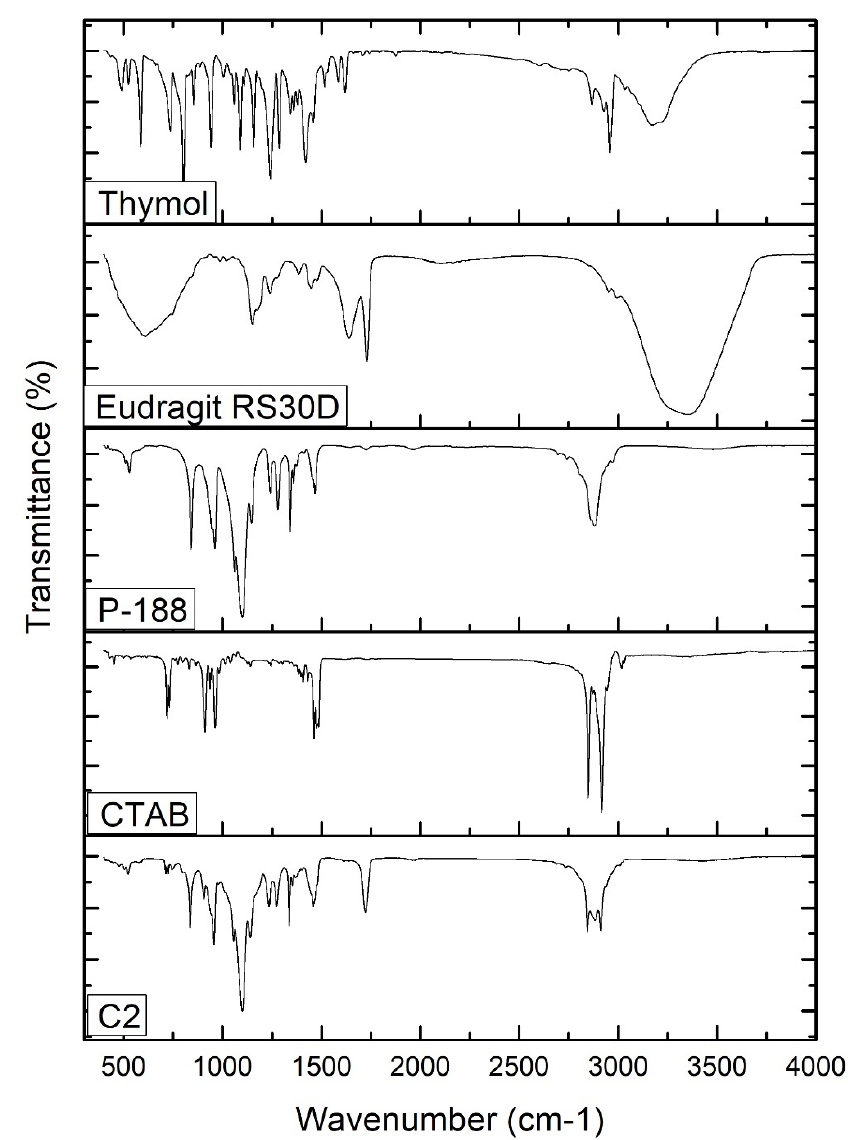
Figure 3. FT-IR spectra of thymol, Eudragit RS30D, P-188, CTAB, and thymol-loaded CPNPs C2.